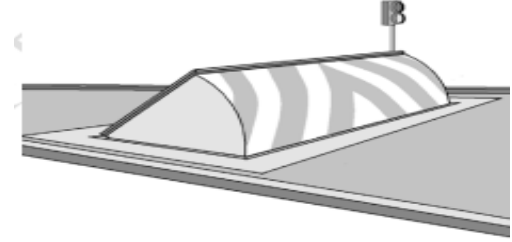
Figure 10. Example of a deployable vehicle barrier [19]